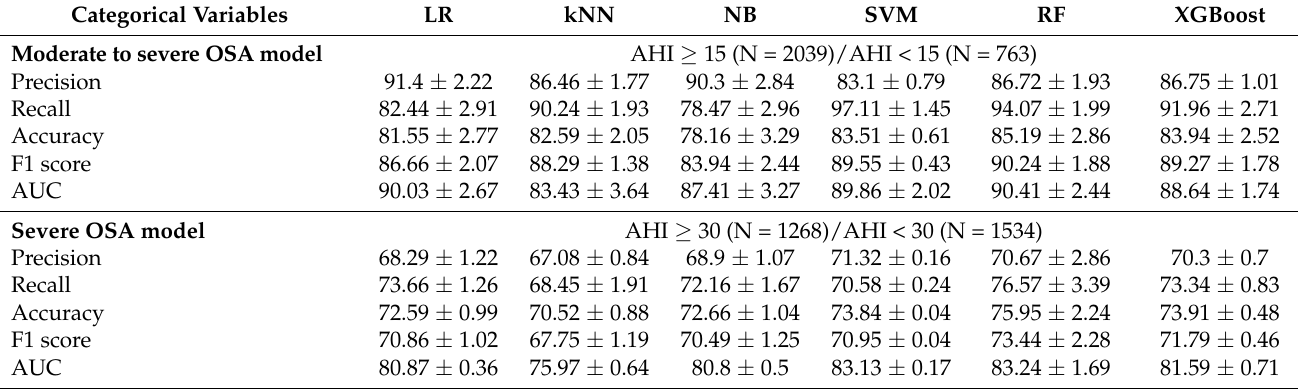
Table 4. Accuracy of the models for screening moderate to severe and severe OSA when using grid search cross-validation with the training data set.